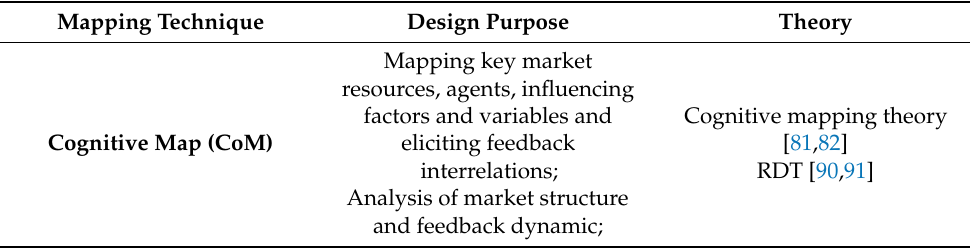
Table 1. Cognitive and agent mapping